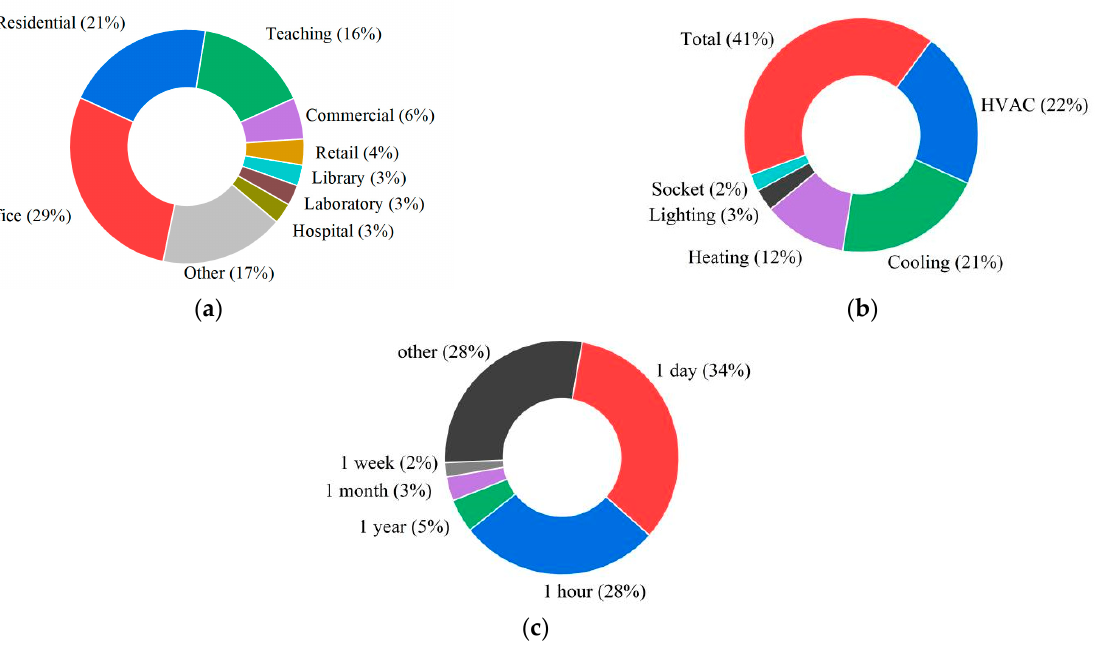
Figure 4. Distribution of the reviewed papers according to ( a ) type of building; ( b ) type of building energy consumption; and ( c ) type of prediction time scale.